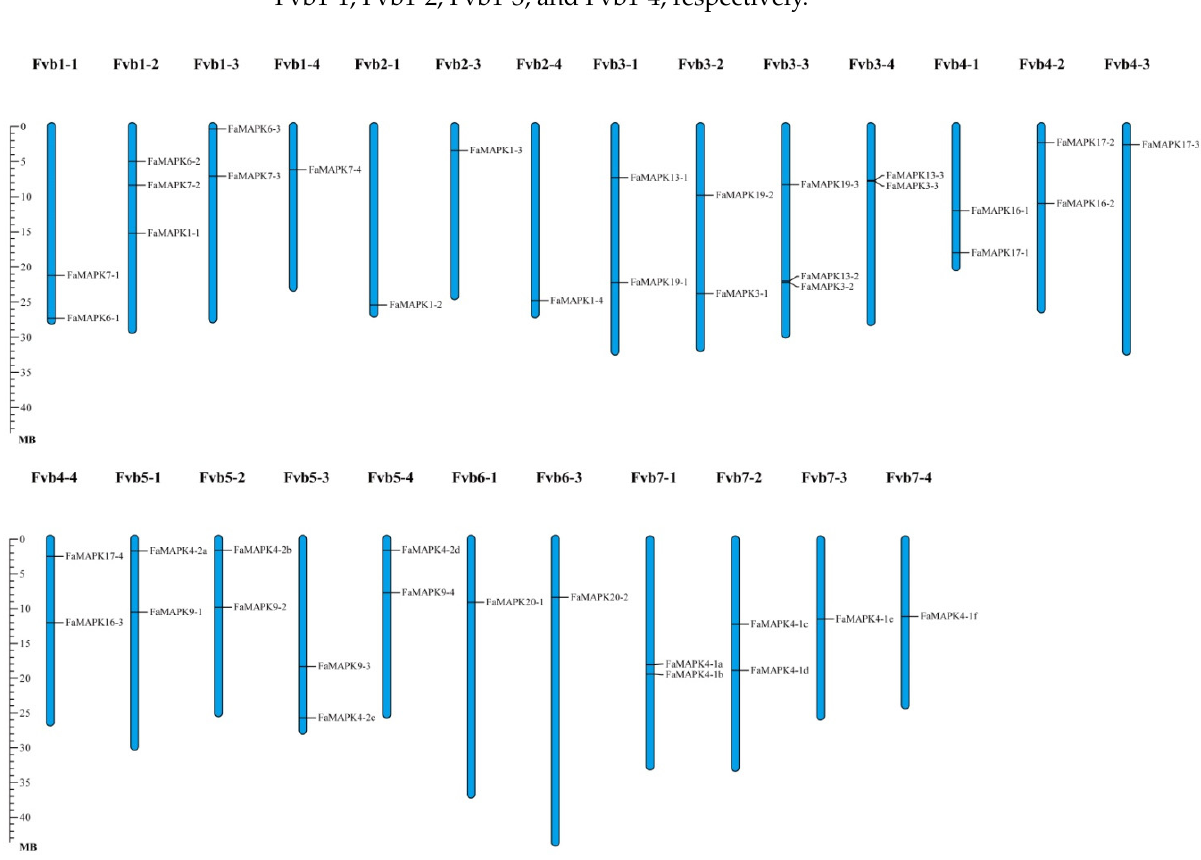
Figure 1. Chromosomal localization of the FaMAPKs. The chromosome number is indicated at the top of each chromosomal. The Fvb2-2, Fvb6-2 and Fvb6-4 chromosomes without FaMAPK gene localization are not showed.